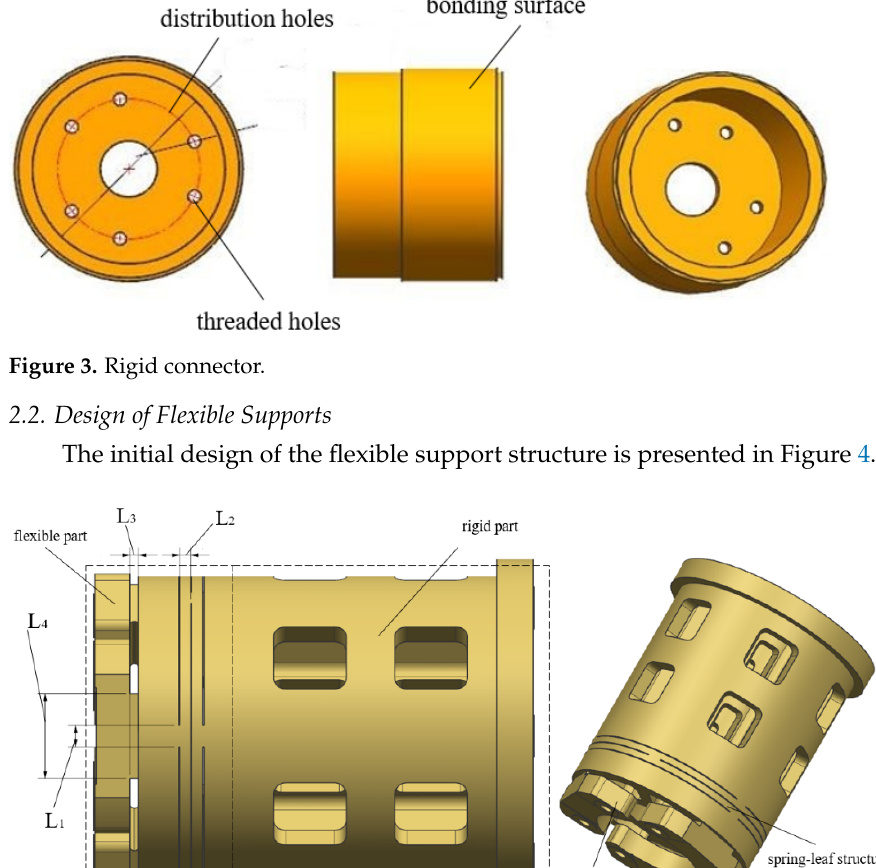
Figure 2. Connection method of the mirror body and rigid connector.